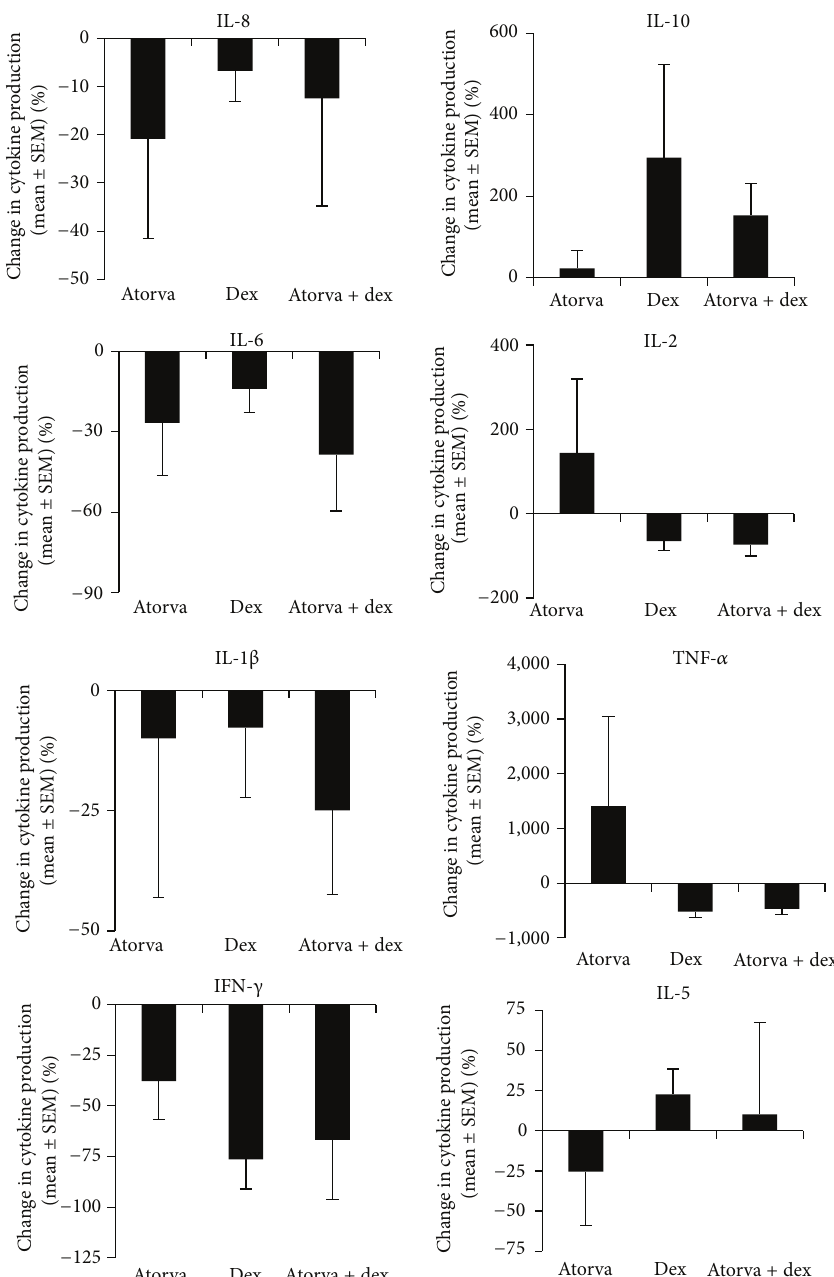
Figure 4: Graphs showing percentage changes in cytokine production in cells stimulated with PMA/ionomycin ± atorvastatin/dexameth-